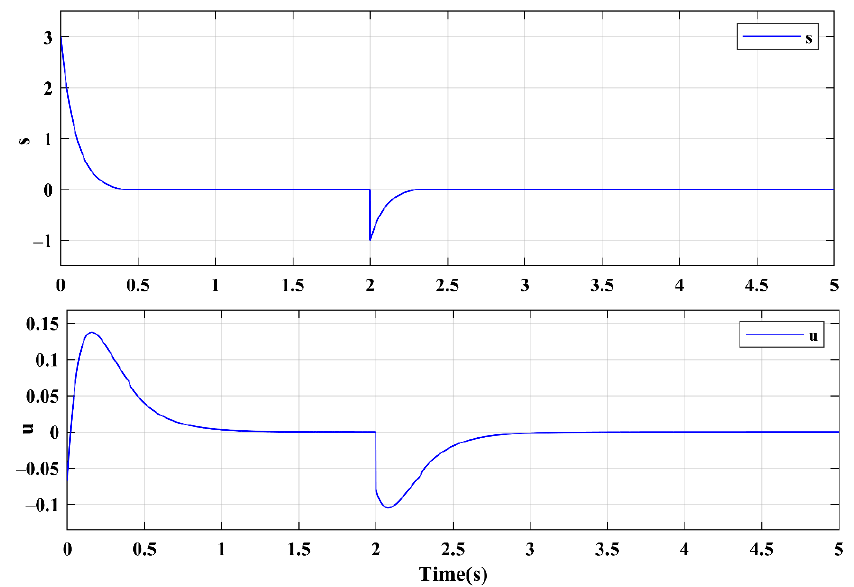
Figure 8. Plot of s and u versus time (SMC).